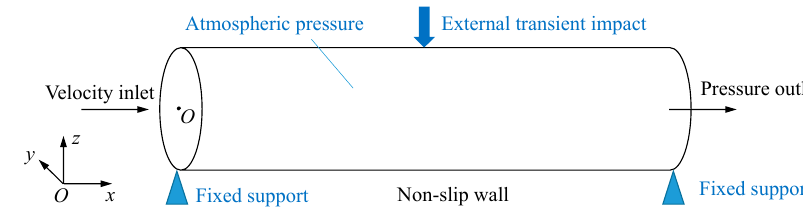
Figure 3. Physical model for the fluid–structure coupling.